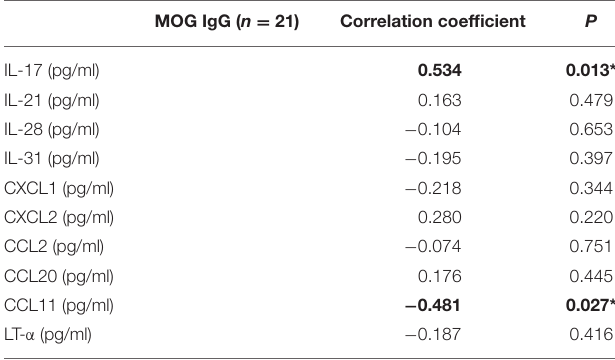
TABLE 3 | Spearman’s correlation coefficient (r) of the association between serum cytokines/chemokines and MOG-IgG titer in 21 MOG-IgG-seropositive ON patients.